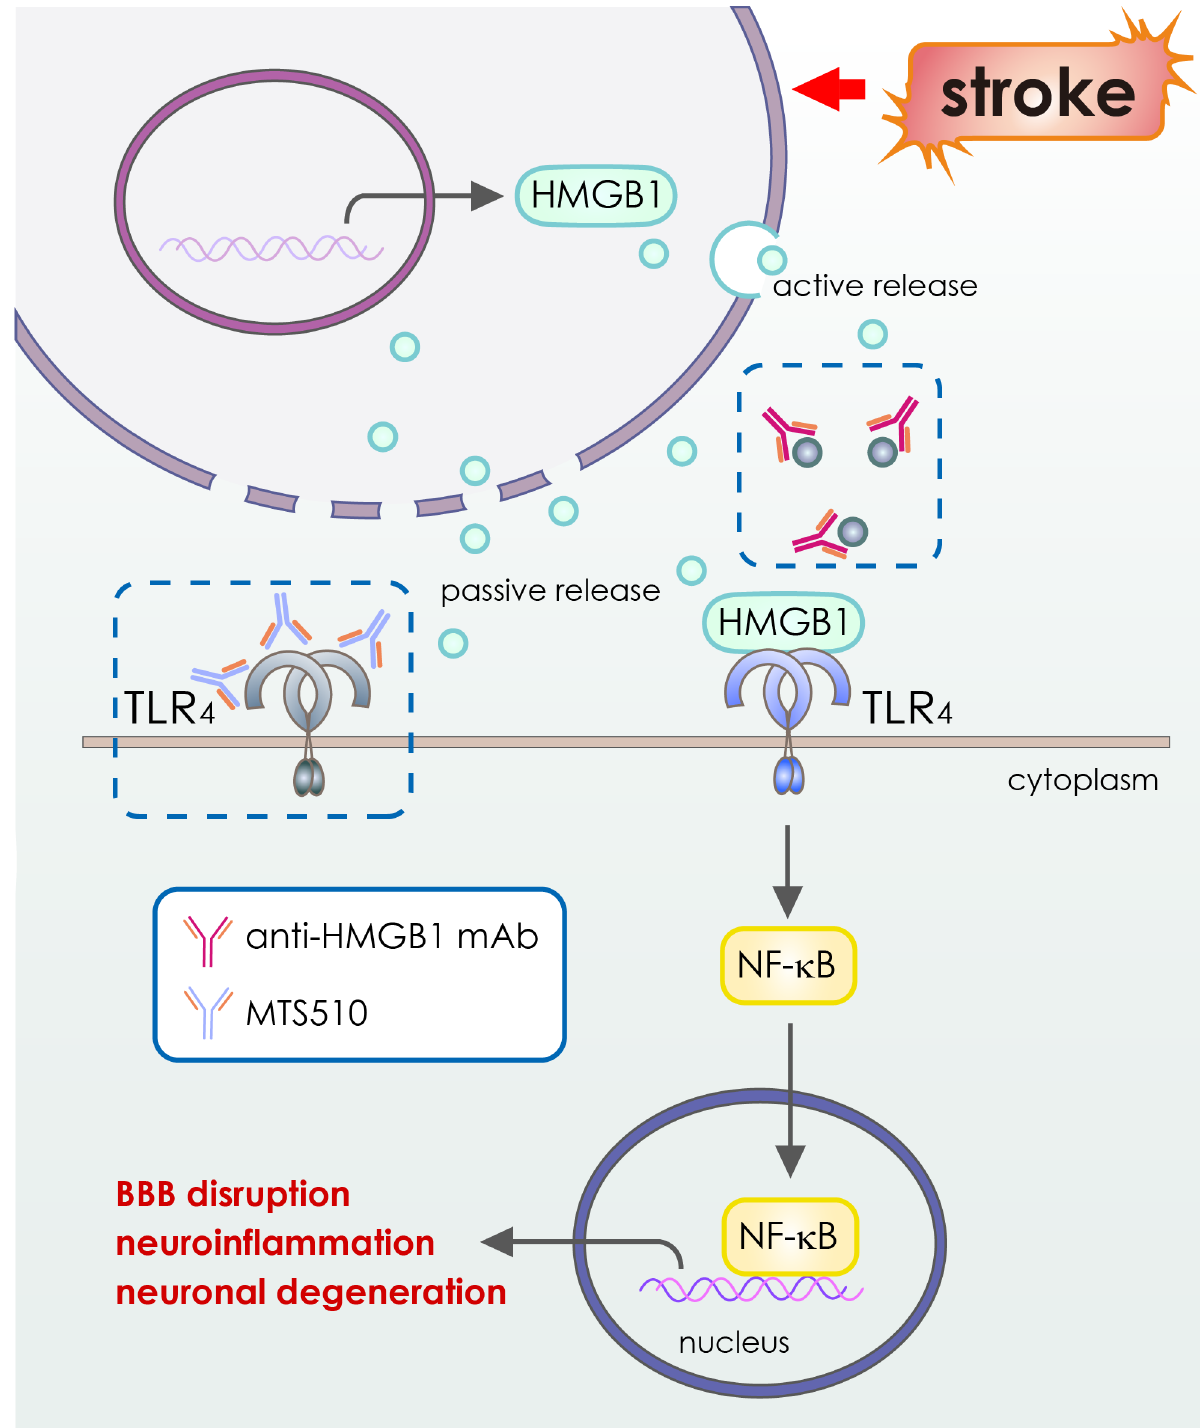
Figure 3. Schematic illustration of function of HMGB1 or TLR4 in the pathology of stroke. The high mobility group box 1 (HMGB1) protein is a typical damage-associated molecular pattern (DAMP) protein that can bind to the toll-like receptor 4 (TLR4) and initiates and activates the NF- κB sig- naling axis. The activation of the NF- κB pathway significant ly increases the production of pro-inflammatory cytokines, including TNF- α, IL -6, and IL- 1β , which causes exaggerated neu- roinflammation, BBB disruption, and neuronal degeneration after cerebral ischemia. Inhibition of TLR4 or HMGB1 with antibody-based drugs can ameliorate the neuroinflammatory responses and neuronal damage after stroke.